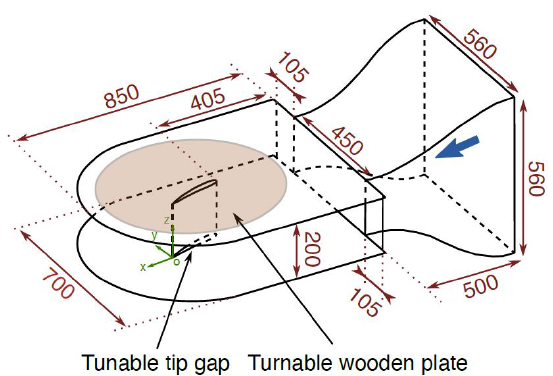
Figure 1. Sketch of the experimental set-up from Jacob et al. [13]. Dimensions are in millimeters. The airfoil is a NACA 5510 of chord c = 200 mm. The geometrical angle of attack is β = 16.5 ◦ . The gap height is s = 10 mm. The mean flow velocity at the exit nozzle is U 0 = 70 m/s, corresponding to a Mach number Ma = 0.20 and a Reynolds number based on the chord Re = U 0 .c/ ν = 9.3 × 10 5 . One chord upstream of the airfoil, the boundary layer thickness on the plate is 6.2 mm. The experiment was carried out under ambient pressure p a = 97,700 Pa and ambient temperature T a = 290